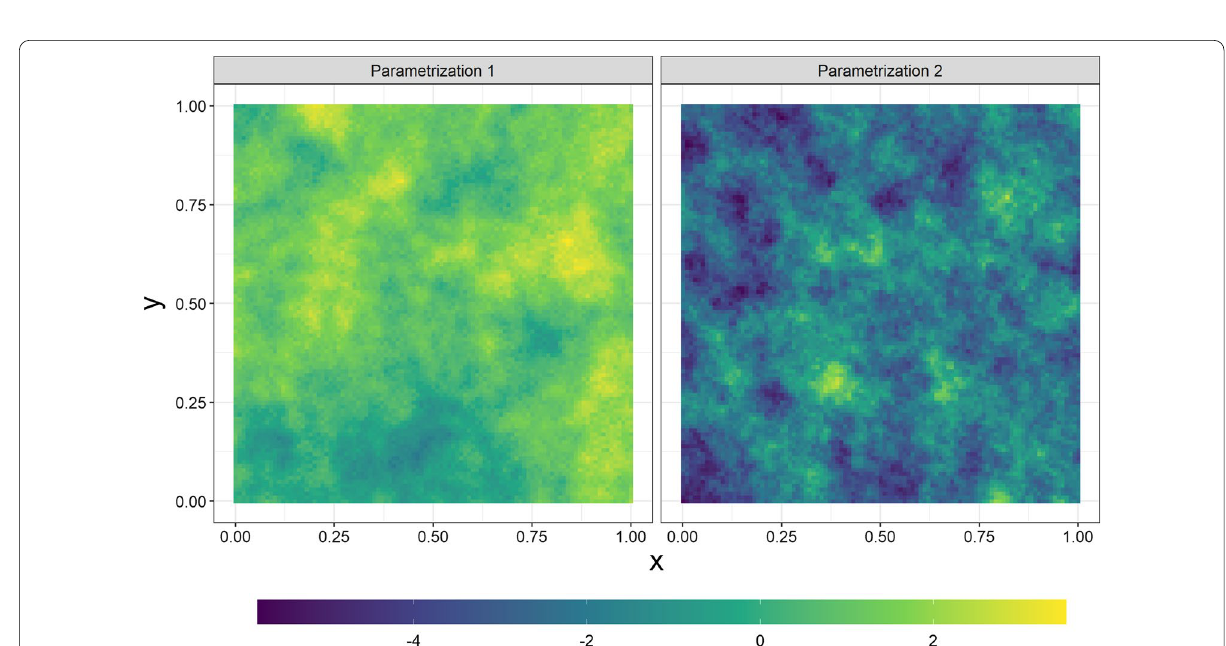
Fig. 3 Visualization of two sampled Gaussian processes. The parametrization and covariance functions are given in Table 1 and Fig. 2, respectively. The Gaussian processes values are given at the respected coordinates x and y in the unit square by the color